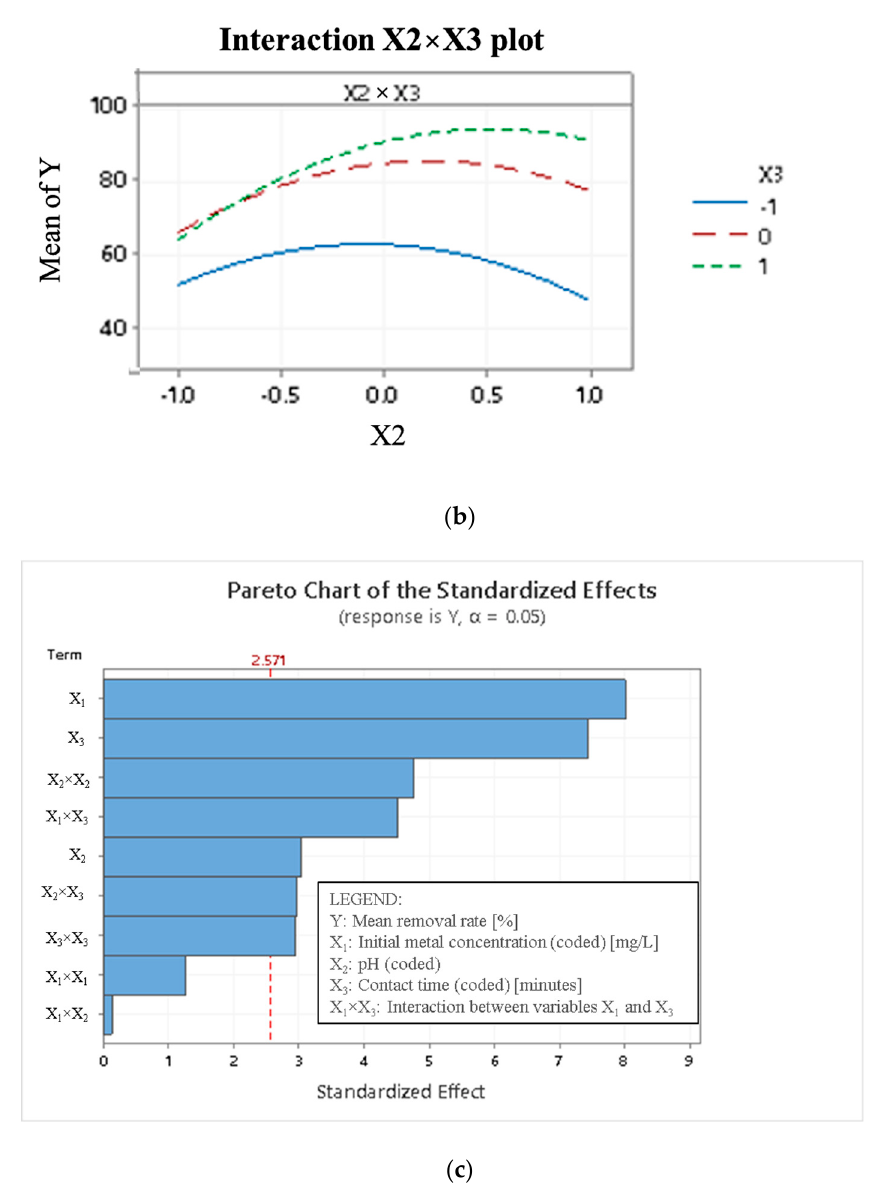
Figure 5. ( a ) Contribution of the main factors X 1 , X 2 , and X 3 on explaining Y. ( b ) Interaction plots. ( c ) Pareto Chart of parameter effects on the removal efficiency for Cd 2+ .